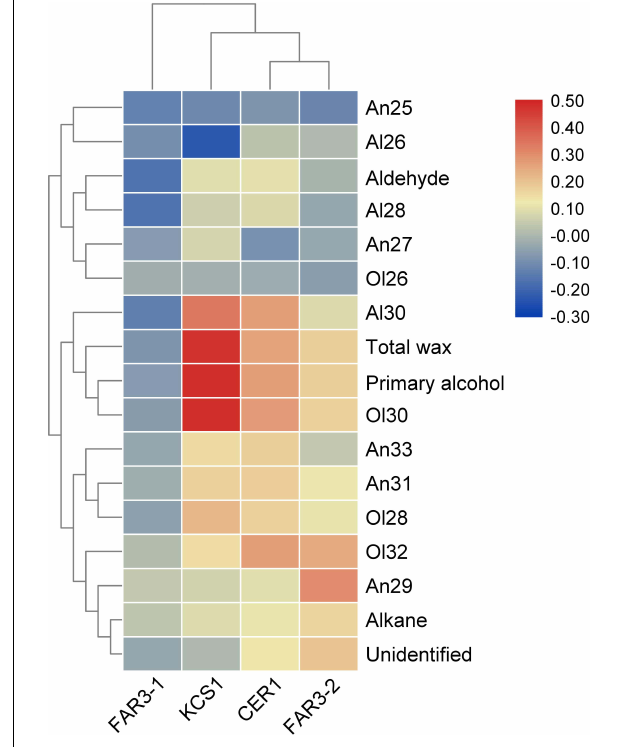
of the four wax genes were cloned from 30 populations, including the MrFAR3-1 CDS from 25 populations, the MrCER1 CDS from 11 populations, and the MrKCS1 CDS from 30 populations ( Table 2 ). No CDS could be cloned for MrFAR3-2 except for TMT. From the cloned populations, MrKCS1 had higher